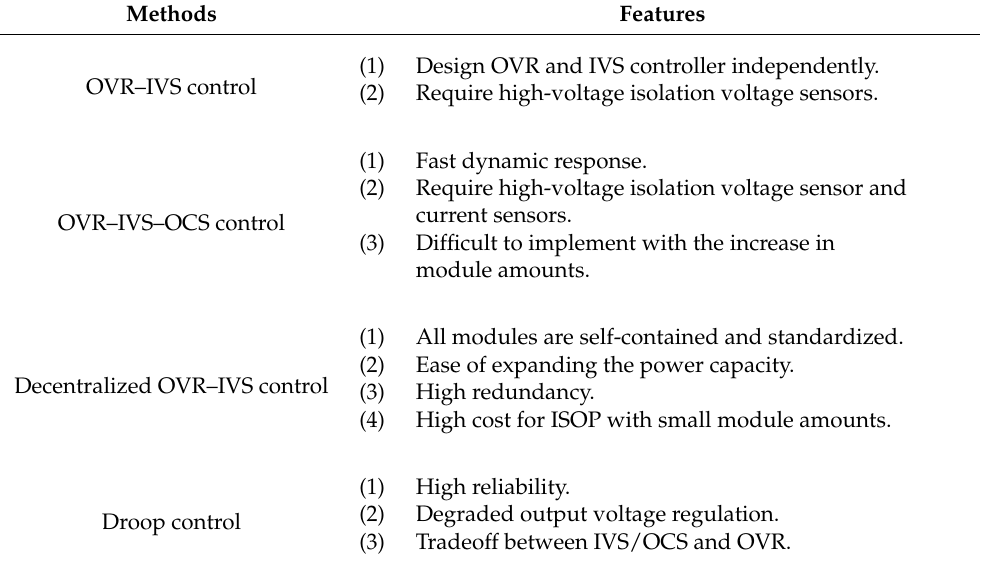
Table 2. Comparison of the ISOP control